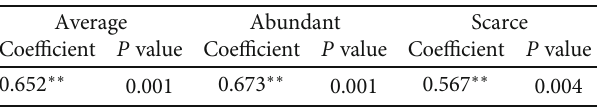
Figure 7: Twenty-four-hour load pro fi le and net load curve of LP5 at 30% solar penetration under abundant solar resource conditions. Table 6: Results of 2-tailed tests showing the solar load correlation coe ffi cients and P values of LP5 under average, abundant, and scarce solar resource conditions.